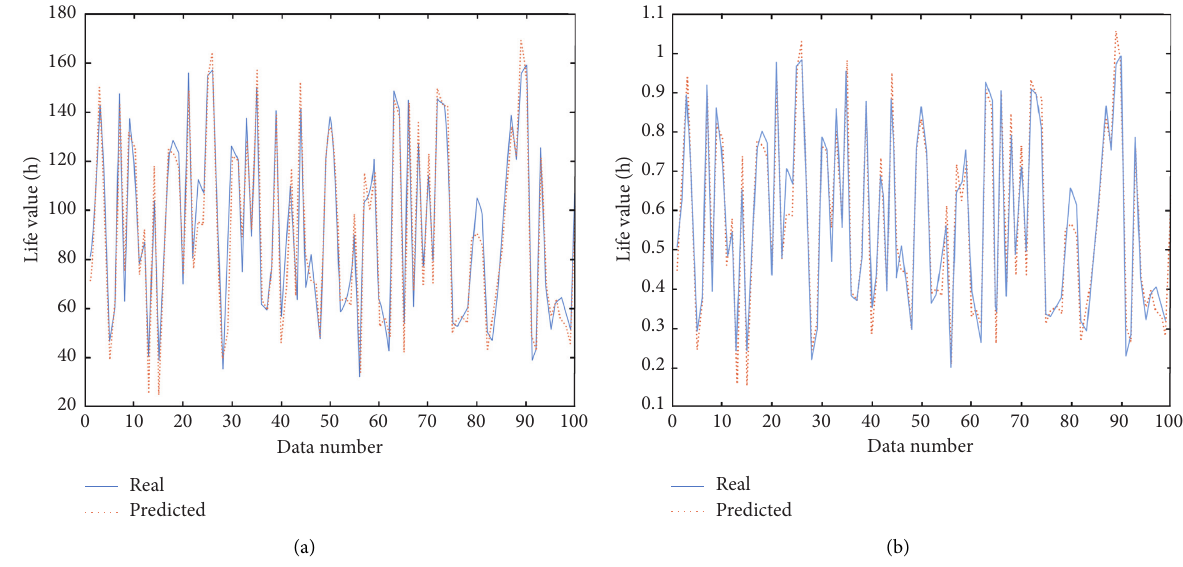
Figure 8: Comparison of the life values of testing samples. (a) Initial comparison. (b) Comparison after